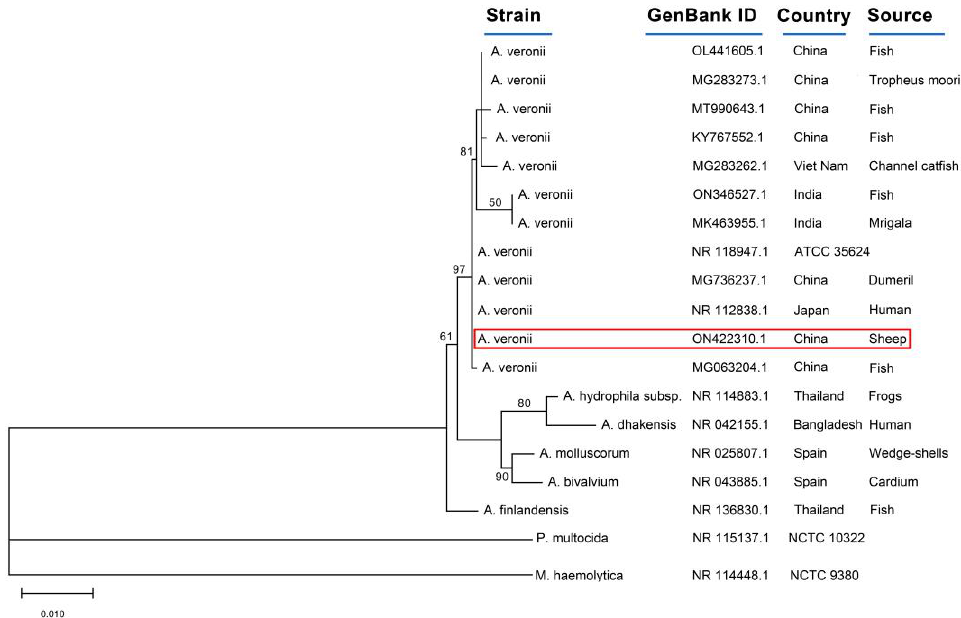
Figure 4. Phylogenetic tree of 16SrRNA in A. veronii YL4077 isolated from dead sheep in China. A red line indicates the isolate from this study. The numbers in each node are the confidence values. The distance bar is the number of nucleotide substitutions per site.